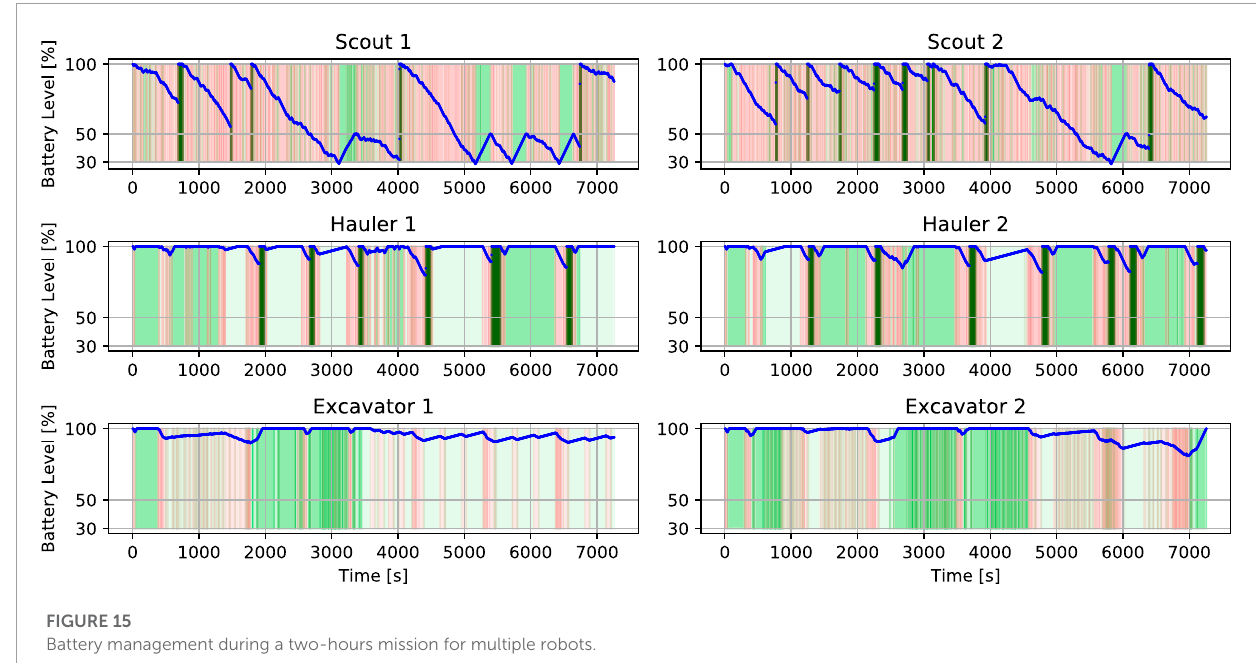
FIGURE 15 Battery management during a two-hours mission for multiple robots.